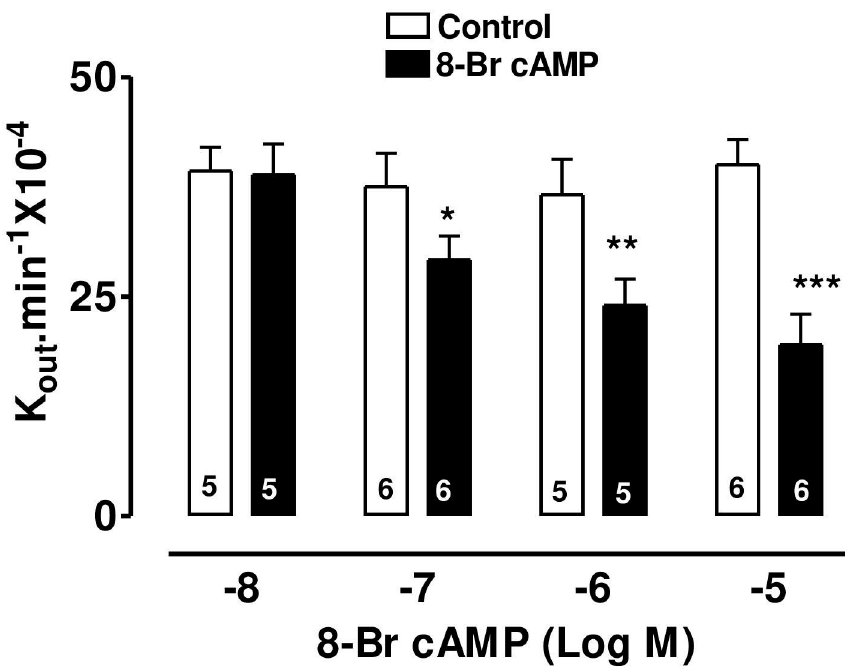
Fig 3. The effect of 8-Br-cAMP on AH formation rate in the bovine isolated perfused eye measured by fluorescein dilution technique. AH formation rate was expressed as the rate constant (K out .min -1 × 10 − 4 ), defined as the slope of the regression line drawn on LN (Log e ) of the changes of fluorescence with time (min). Each value is a mean s.e.mean of the number (n) of experiments shown at the base of each column. In order to eliminate individual variation, control and treated data were obtained from the same eye. AH formation rate measured during the first 30 min prior to drug application was taken as the control value. AH formation rate for the subsequent 40–60 min after establishment of drug effects was taken as the treated value. Note that after addition of drug, 20 min stabilization period was allowed to establish drug effect. Significance of differences from controls; � p < 0.05, �� p < 0.01 and ��� p < 0.001.